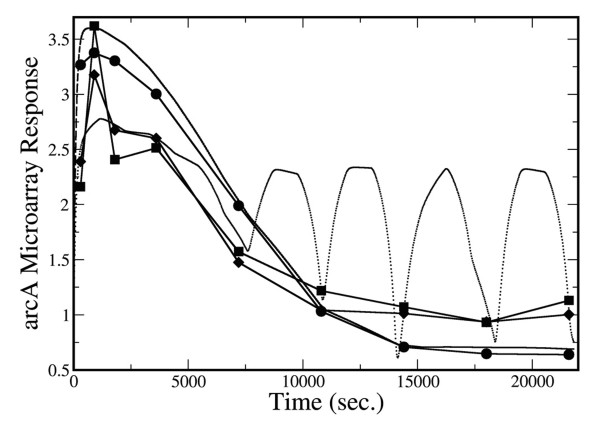
Comparison of predicted and observed microarray response for arcA. Diamonds indicate the experimental microarray response; squares indicate the experimental microarray response with 25% added noise; Circles indicate the predicted microarray response before adding 25% noise. Using data with 25% added noise, doted-line indicates the simulated microarray response when no regularization was imposed on the TF activity time courses, while the dashed-line is the microarray response when regularization was imposed on the TF activity time courses.